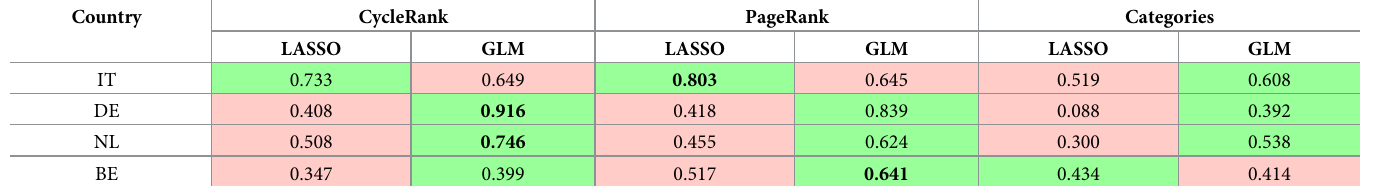
Table 4. PCC comparison between LASSO and GLM best models. The bold values indicate the best results. The green colour indicates the best results by either using the GLM or the LASSO model, by keeping the country fixed (no colour means no changes). Country CycleRank PageRank IT DE NL BE